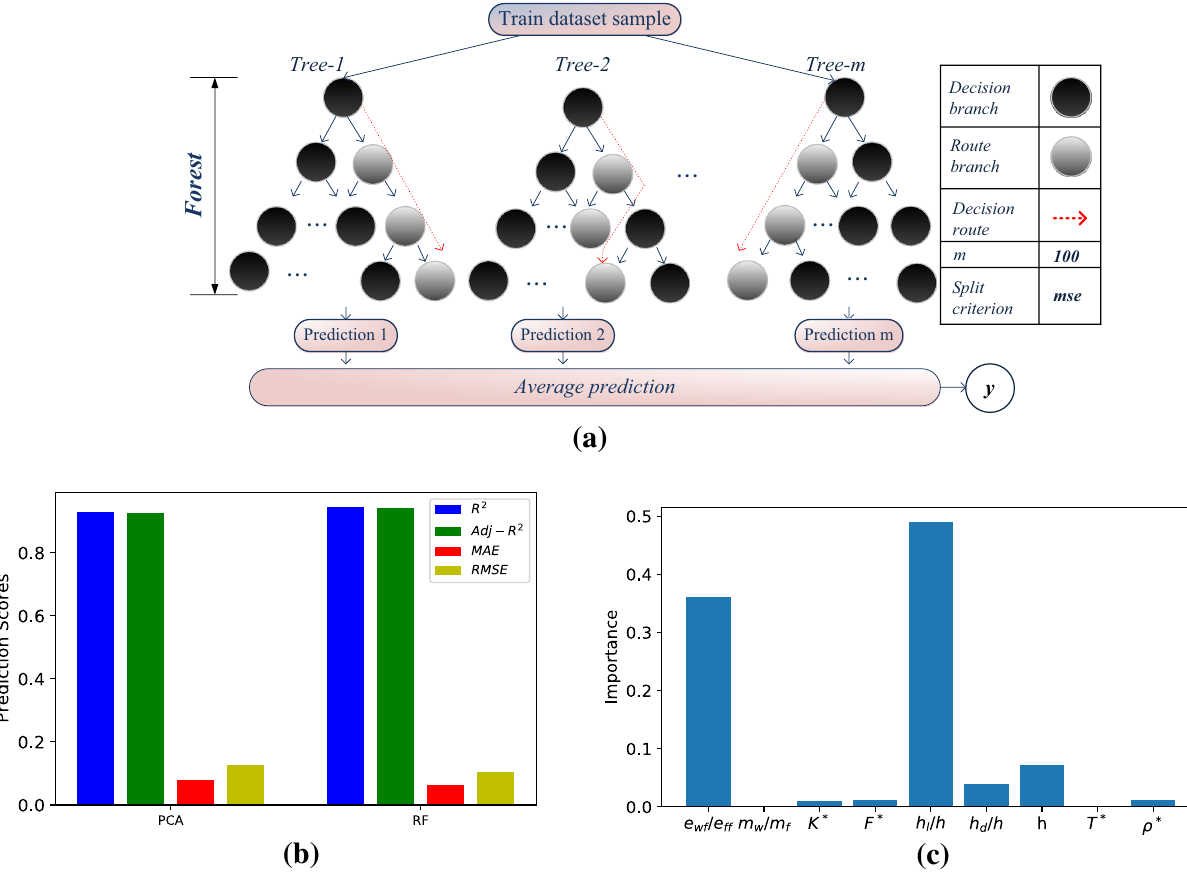
Figure 3. Model and results for the Random Forest (RF), ( a ) data flow, ( b ) bar plot, quantifying R 2 , Adj-R 2 , MAE, and RMSE for the RF and the PCA models, ( c ) variable importance bar